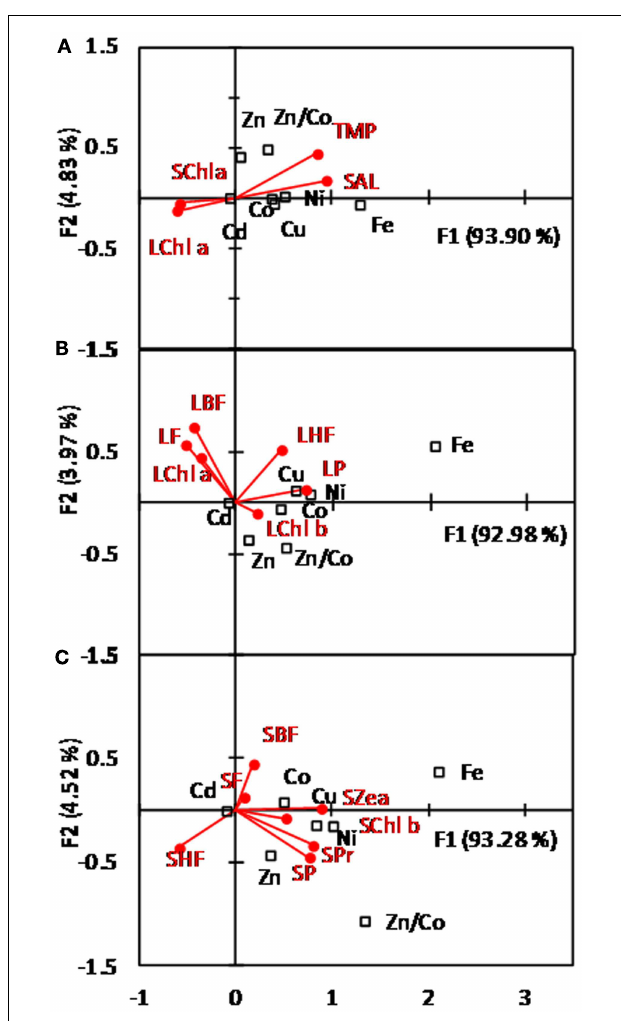
FIGURE 10 | Symmetric CCA map between micronutrients defined as objects (square) and physical and biological variables (red dots). (A) considers micronutrients with the physical variables temperature (TMP) or salinity (SAL) and the variable chlorophyll (Chl a ) from the large (L, > 10 µ M) or small (S, 0.8–10 µ M) phytoplankton community. Relations between micronutrients with the biomarker pigments associated with the large (L) and small (S) phytoplankton community are represented in (B) and (C) , respectively. Micronutrients are cobalt (Co); nickel (Ni); copper (Cu); zinc (Zn); cadmium (Cd); iron (Fe). Biomarker pigments are Chlorophyll (C); Peridin (P); 19-But-Fucoxanthin (BF); Fucoxanthin (F); 19-Hex-fucoxanthin (HF); Prasinoxanthin (Pr); zeaxanthin (Zea). Data for Fe are from Lannuzel et al.